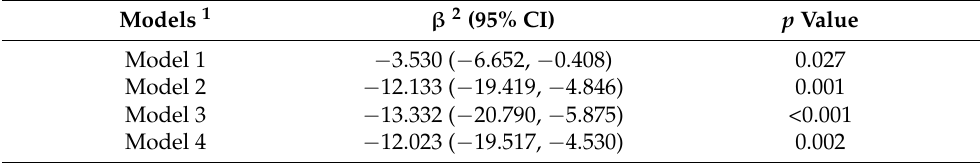
Table 2. Association between sagittal abdominal diameter and serum klotho concentration.